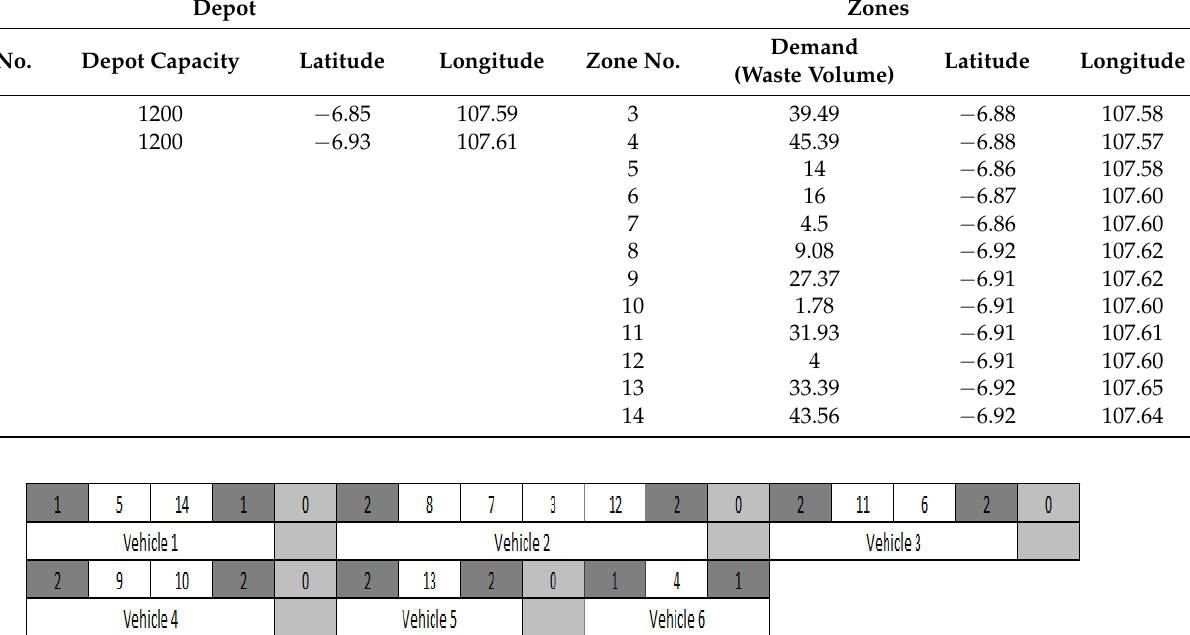
Table 5. An example of depot and zone attributes.